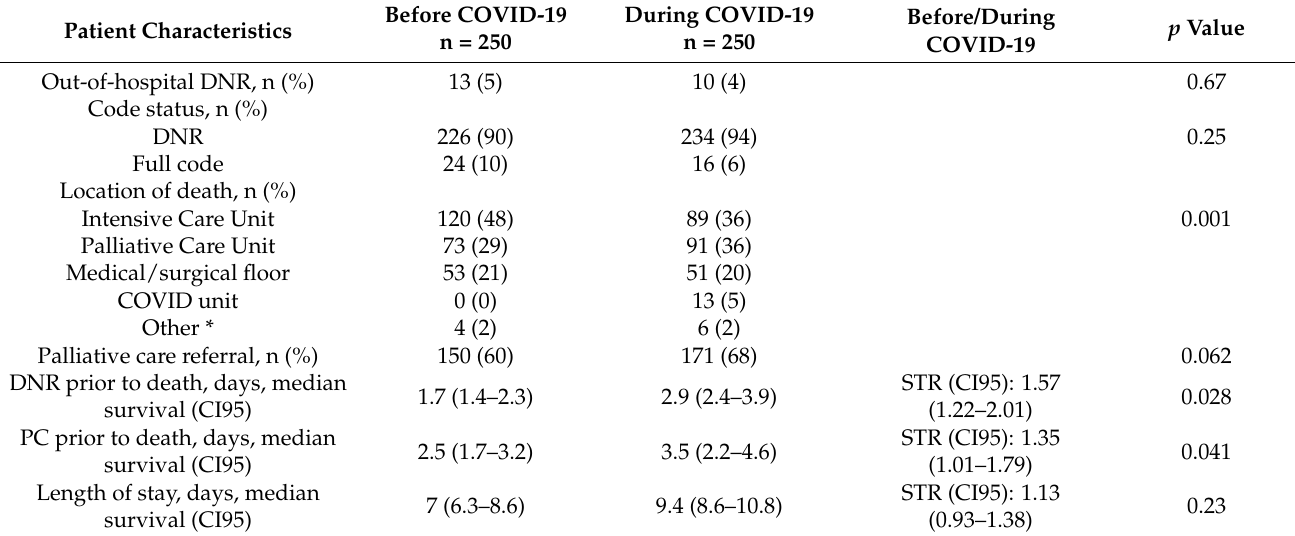
Table 2. Outcomes of inpatient deaths before and during the COVID-19 pandemic (n=500).